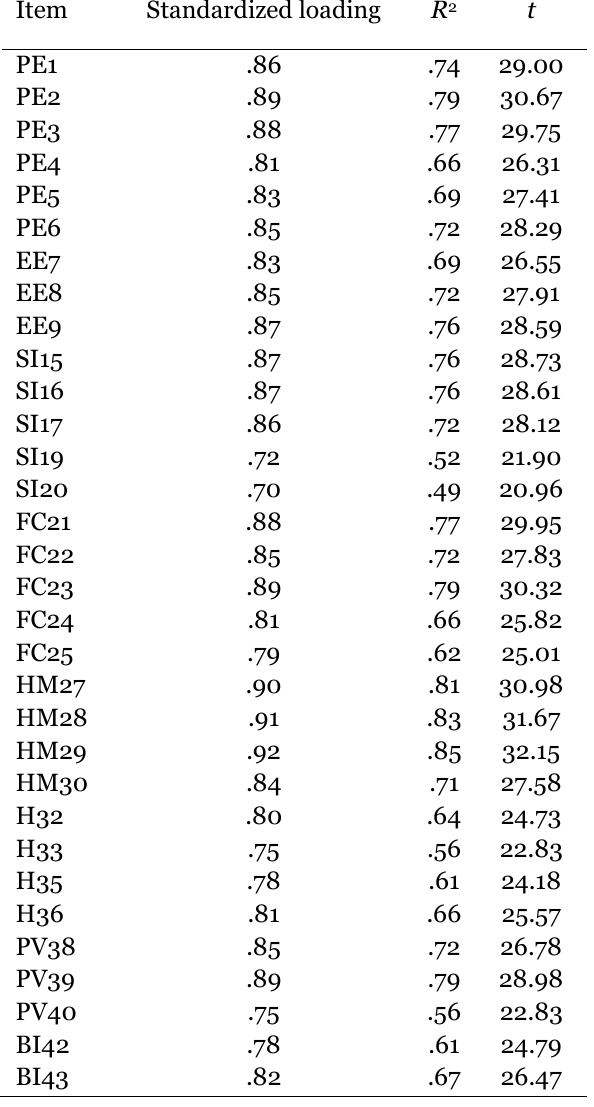
Standardized Factor Loadings, Squared Standardized Factor Loads ( R 2 ), and t Distribution for the Modified 8-Factor Construct of m-TASLM